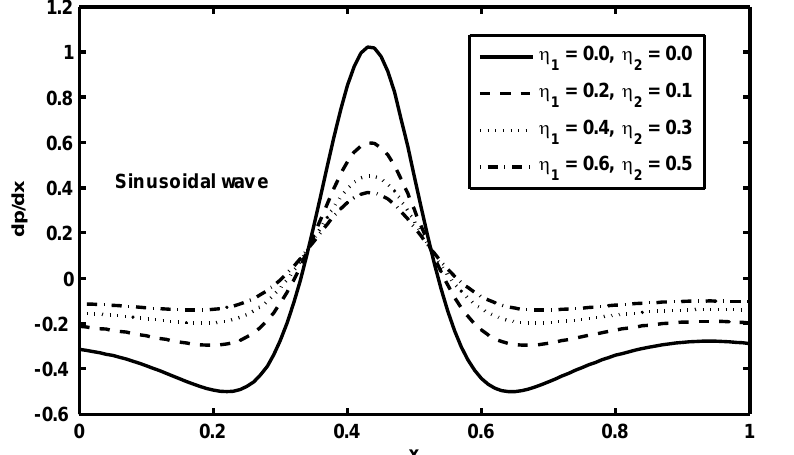
Figure 8. Variation of dxdp / with x for different values of for fixed